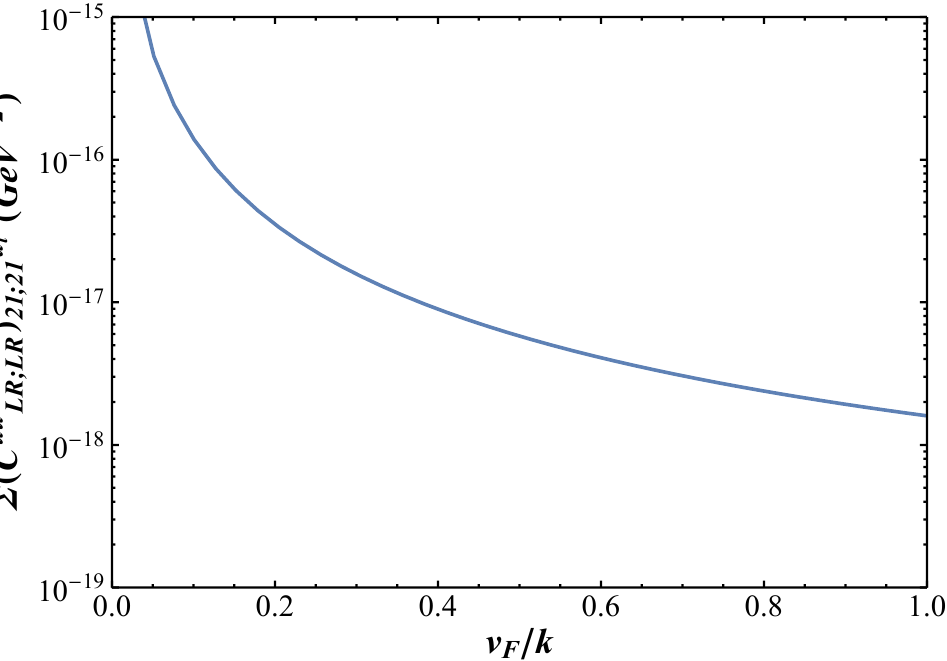
( C uu ) a i de(cid:12)ned 21;21 LR ; LR i =1